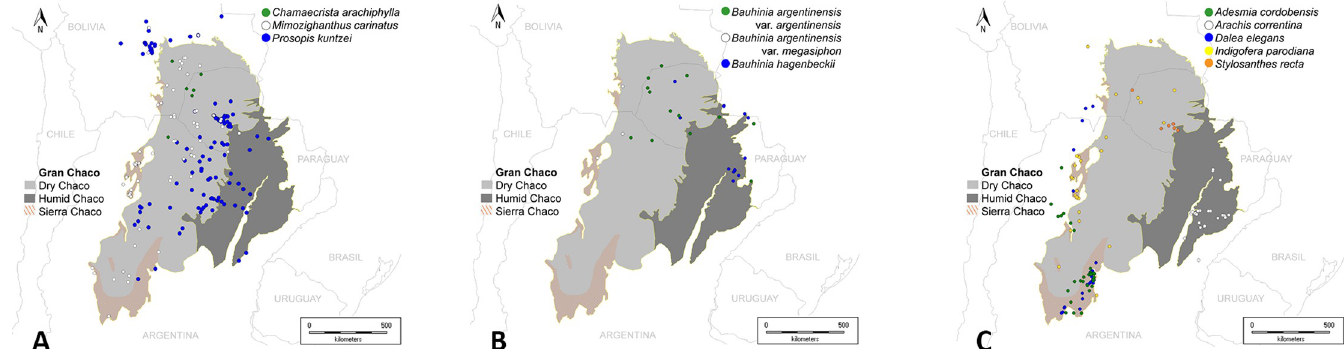
Fig 3. Distribution in South America of some endemic and typical species of Legumes from the Gran Chaco. A. Distribution in South America of some endemic and typical species of Caesalpinioideae subfamily from the Gran Chaco. B. Distribution in South America of some endemic and typical species of Cercidoideae subfamily from the Gran Chaco. C. Distribution in South America of some endemic and typical species of Papilionoideae subfamily from the Gran Chaco.